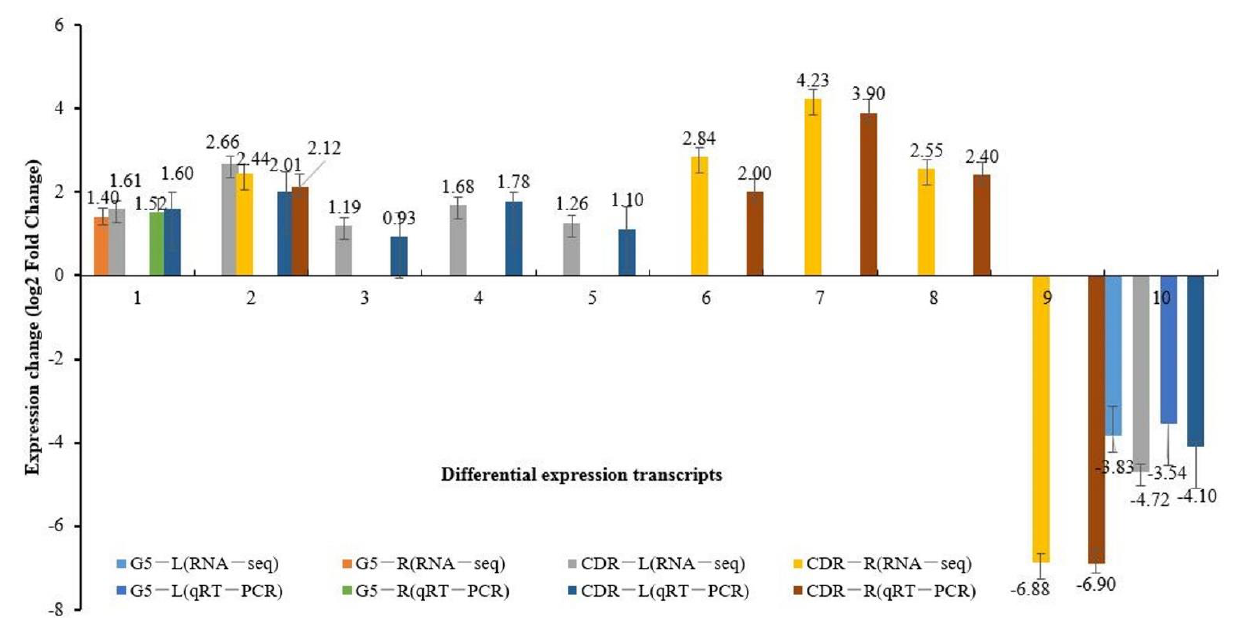
Figure 4. Changes in gene expression levels were confirmed using qRT-PCR. G5-L, leaves of Gisela 5; G5-R, root tissues of Gisela 5; CDR-L, leaves of Mahaleb CDR-1; CDR-R, root tissues of Mahaleb CDR-1. Transcripts ID: 1 , Pav_sc0001339.1_g200.1.mk; 2 , Pav_sc0002493.1_g100.1.mk; 3 , Pav_sc0000131.1_g130.1.mk, 4 , Pav_sc0000004.1_g040.1.mk; 5